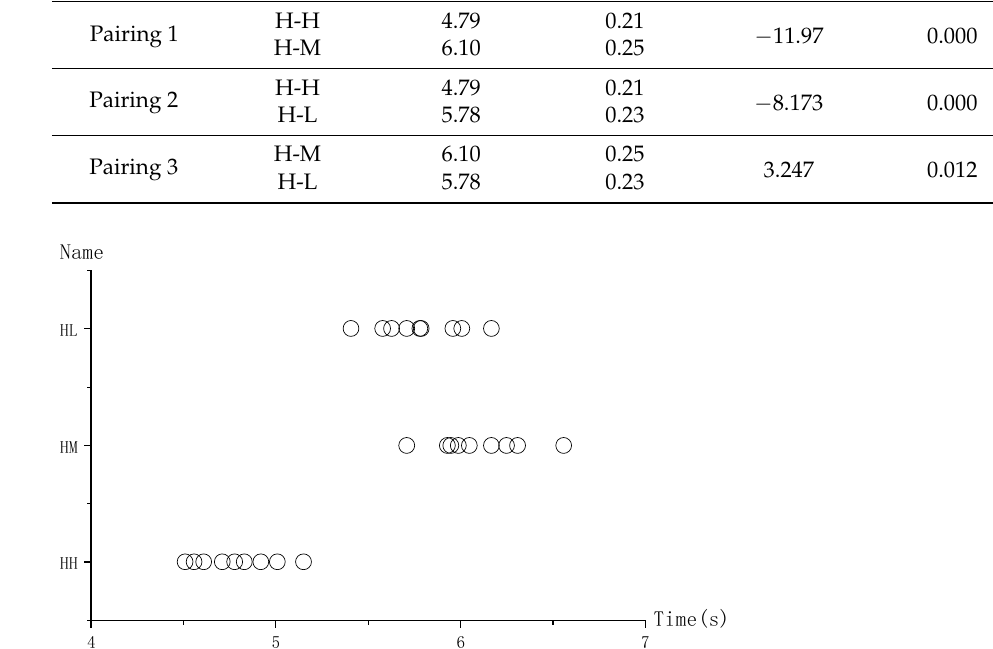
Figure 14. Scatter plot of the response time for each height of the high-pitched indication.